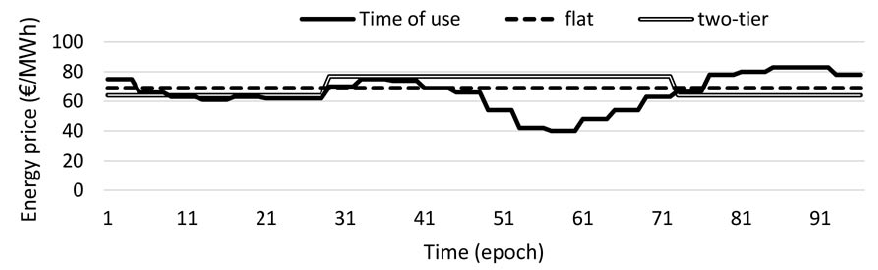
Figure 4. Flat, time of use and two-tier tariff prices. Table 1. Performance assessment of the Energy Manager with respect to optimal and benchmark